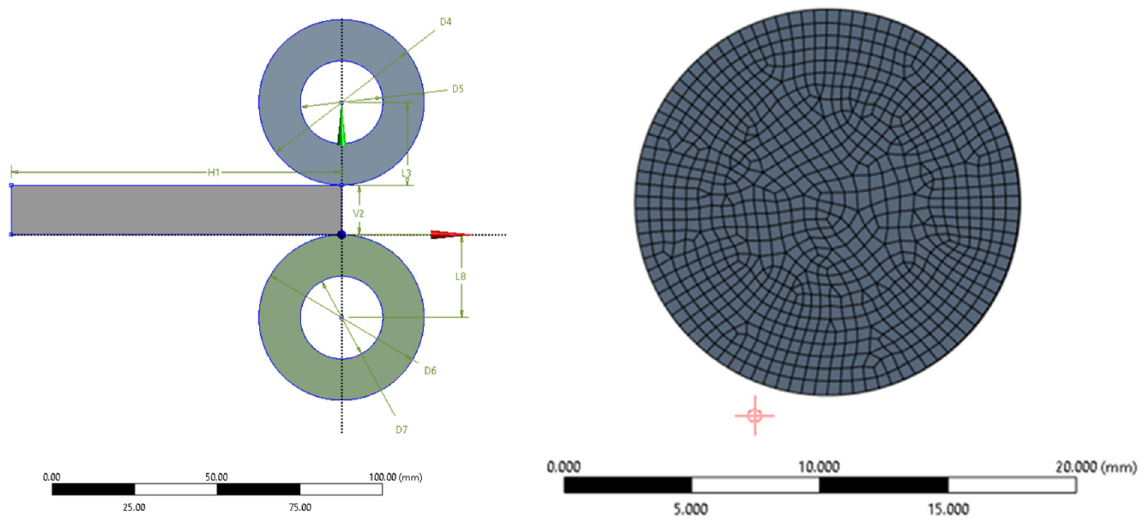
Figure 1. Scheme of the finite element model used in this study and meshes for the